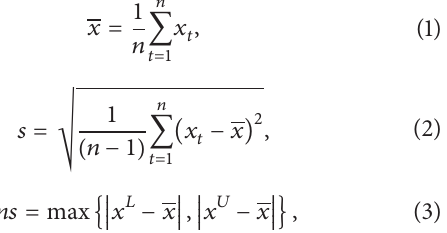
Figure 1: Determinacy-uncertainty space.